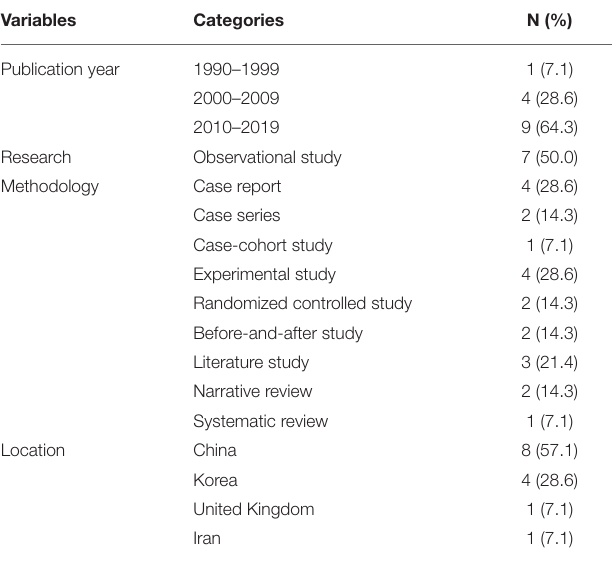
TABLE 1 | General characteristics of studies ( n =